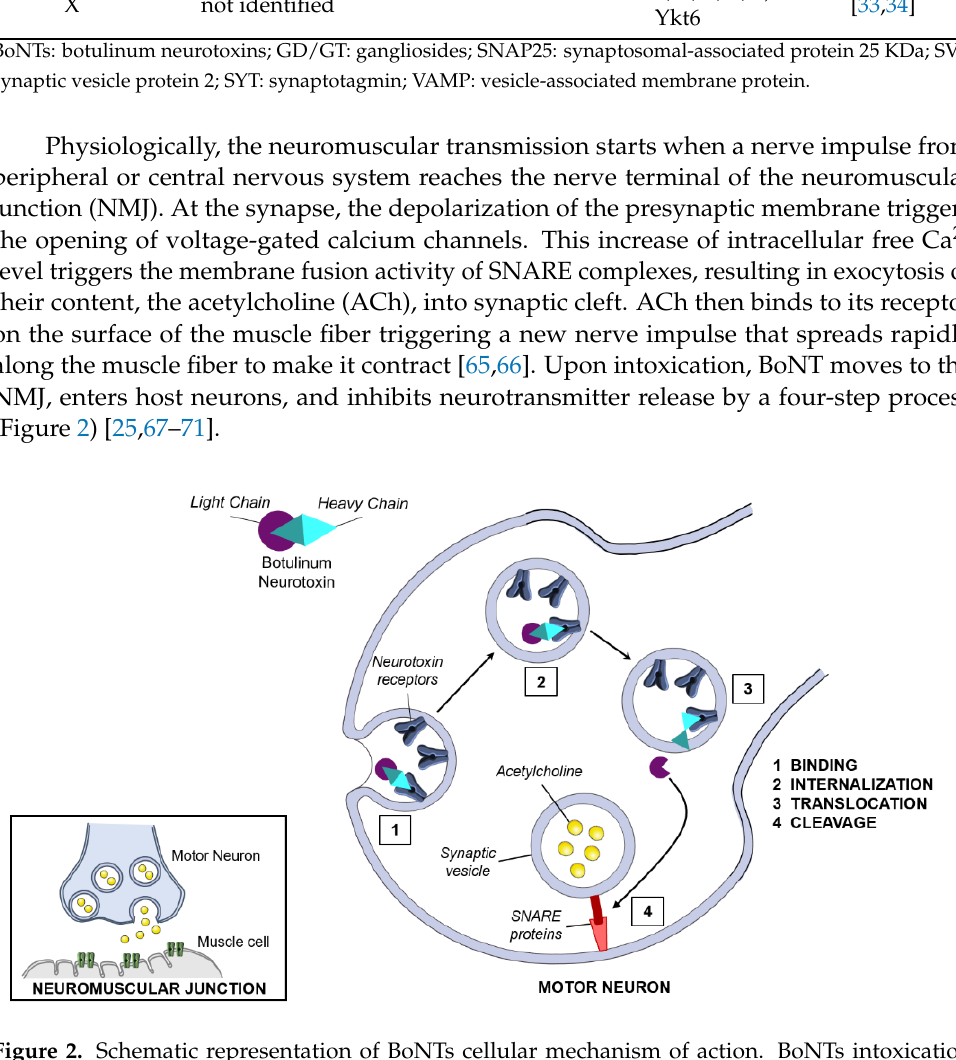
Figure 2. Schematic representation of BoNTs cellular mechanism of action. BoNTs intoxication consists of four steps: binding, internalization, translocation, and cleavage. BoNTs bind to specific receptors via its heavy chain, leading the internalization into the neuron. Once internalized into an endosome, the decrease in pH activates the heavy chain translocation domain, which detaches from the light chain. The light chain moves into the cytosol and binds its appropriate SNARE substrate based on BoNTs serotype. SNARE cleavage blocks the release of acetylcholine into the neuromuscular junction affecting motor neuron function and the resulting muscle contraction.